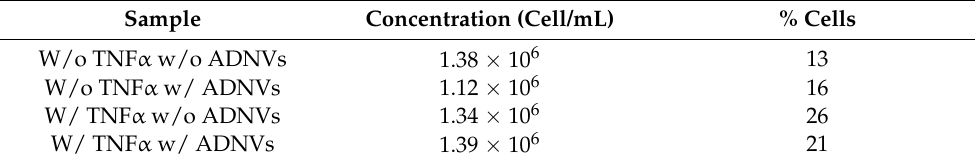
Table 9. Mitochondrial ROS quantification through MitoSOX TM imaging.